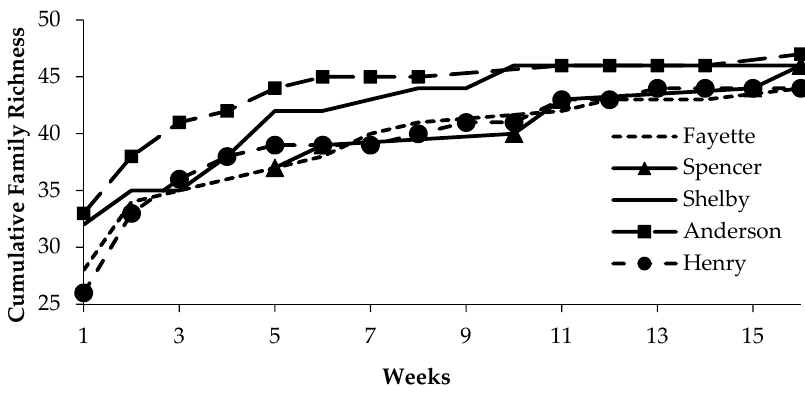
Figure 2. Cumulative coleopteran family richness at five forested sites in north central Kentucky varying in levels of EAB-induced (Emerald Ash Borer-induced) disturbance.